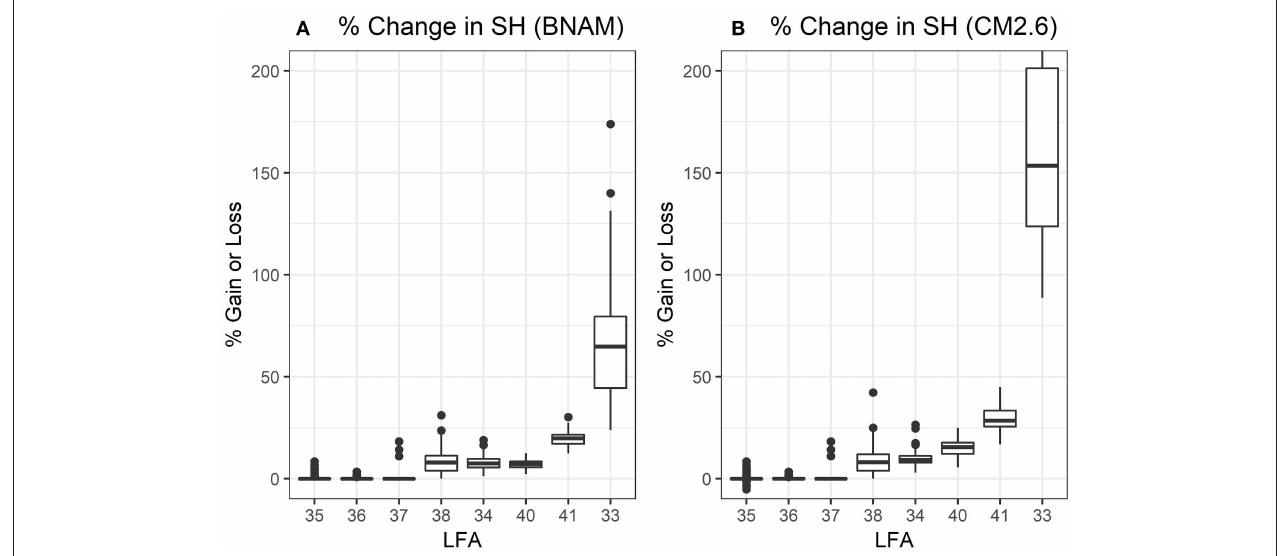
FIGURE 5 | Percent change (gain or loss) in suitable habitat availability for American lobster ( Homarus americanus ). Habitat suitability is measures on a 0–1 scale, where 0 = low likelihood of the species being present and 1 = a high likelihood of species presence. A location was considered suitable if its habitat suitability score from the model output was > 0.3 and distributions were created by calculating percent change between current and projected temperature change scenarios, per Lobster Fishing Area (LFA) based on 100 model iterations. (A) Percent change in suitable habitat availability given the BNAM temperature change scenario. (B) Percent change in suitable habitat availability given the CM2.6 temperature change scenario.